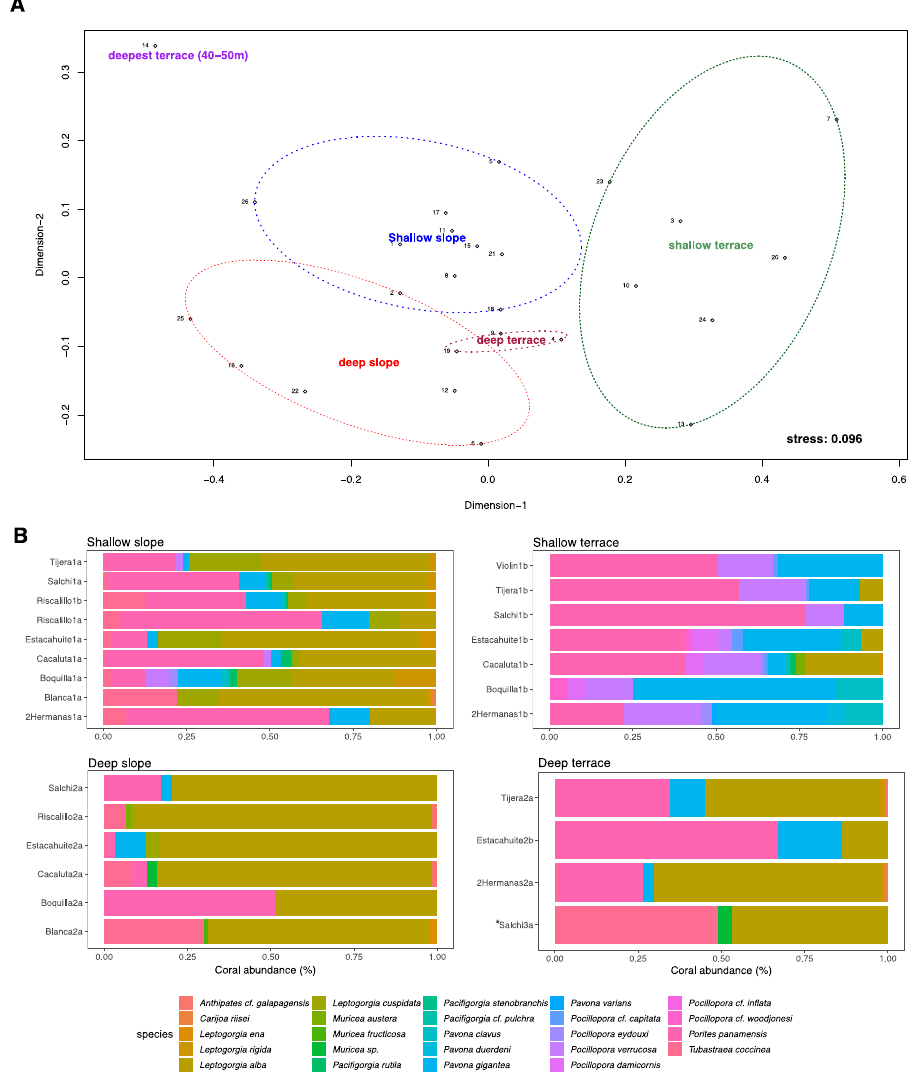
Figure 5. Non-metric multidimensional scaling ordination using photosynthetic and non-photosynthetic coral composition from the two-depth stratum (10 < 20 m and 20 < 30 m): ( A ) each ellipse represents one type of seascape based on Bray–Curtis dissimilarity matrices (2D, stress = 0.096); and ( B ) total cumulative percentage of the relative abundance of the 24 coral taxa in the different seascapes. * Only one transect of 40–50 m located in Puerto Á